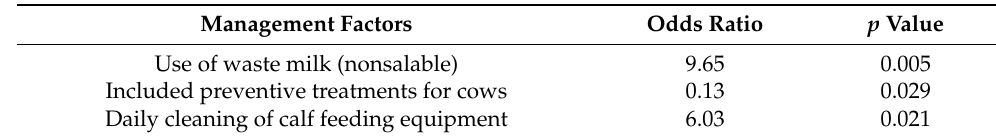
Table 5. Statistics on management factors influencing the level of ESBL/AmpC- E. coli prevalence in calves according to the multivariable logistic regression model.